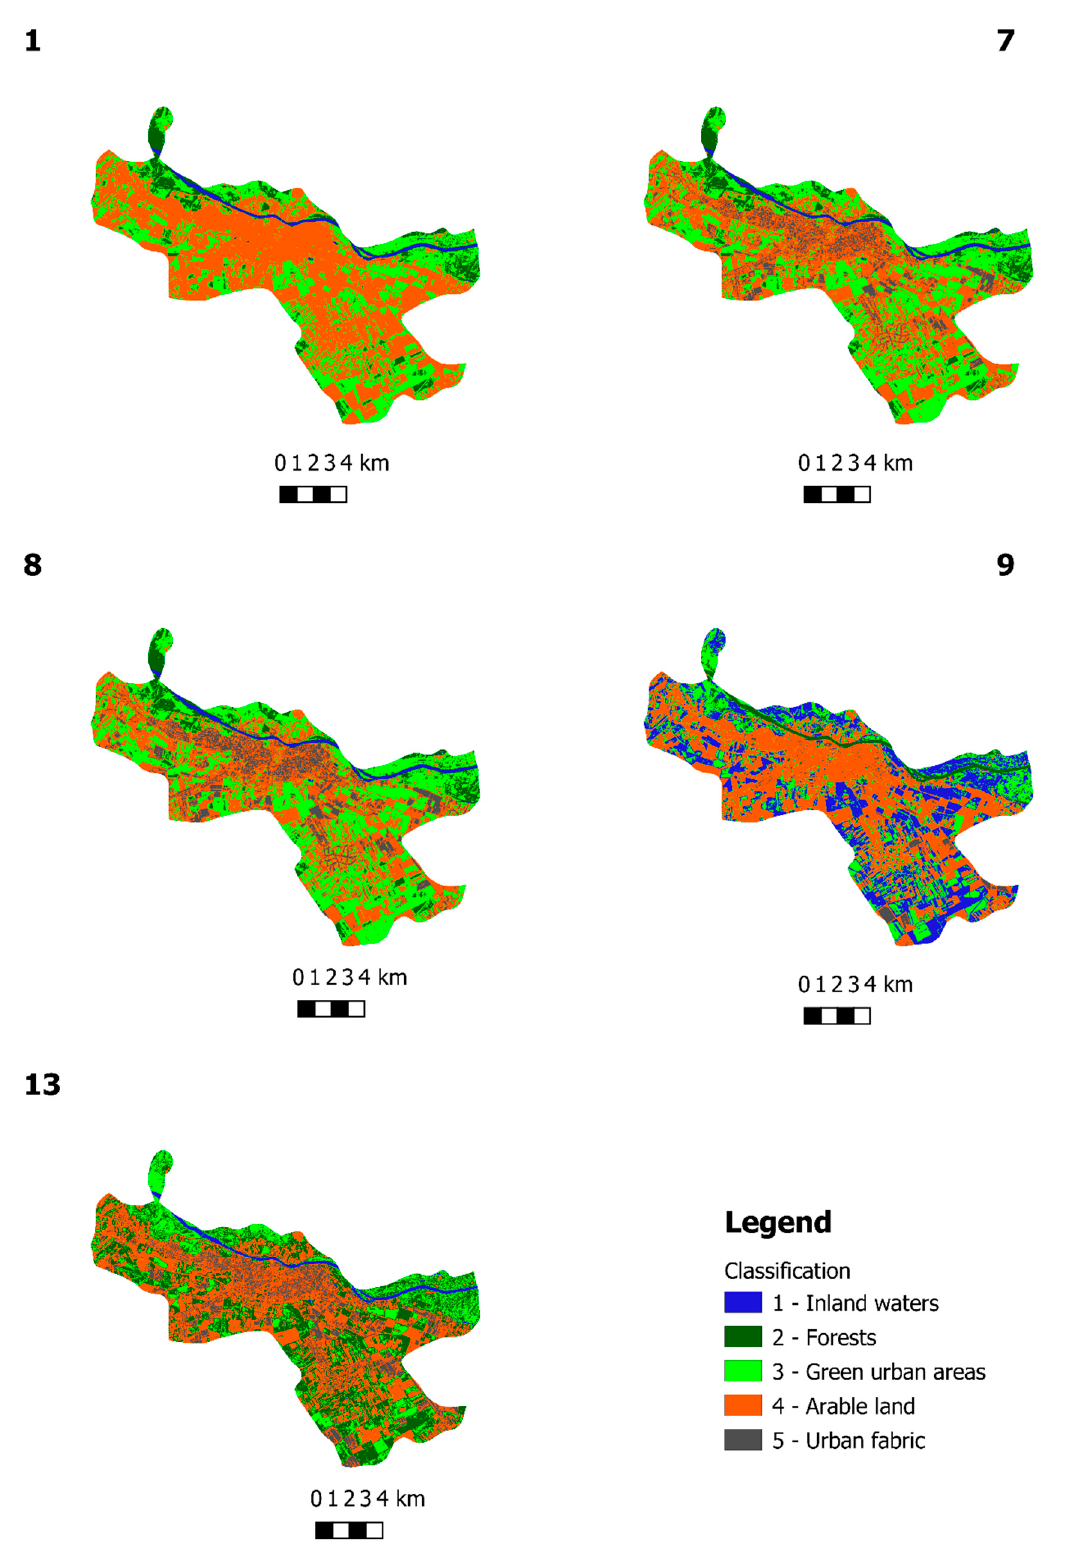
Figure 4. Classification results for the Osijek study area.